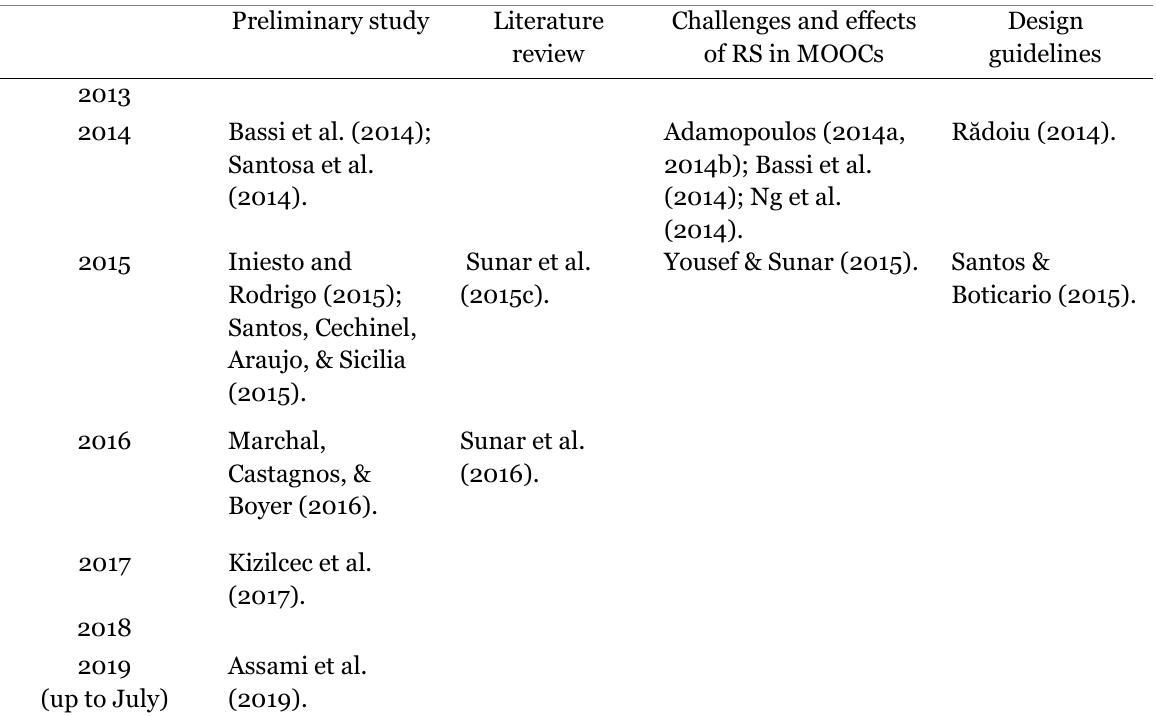
Yearly Distribution of Research Work Discussing Recommender Systems in